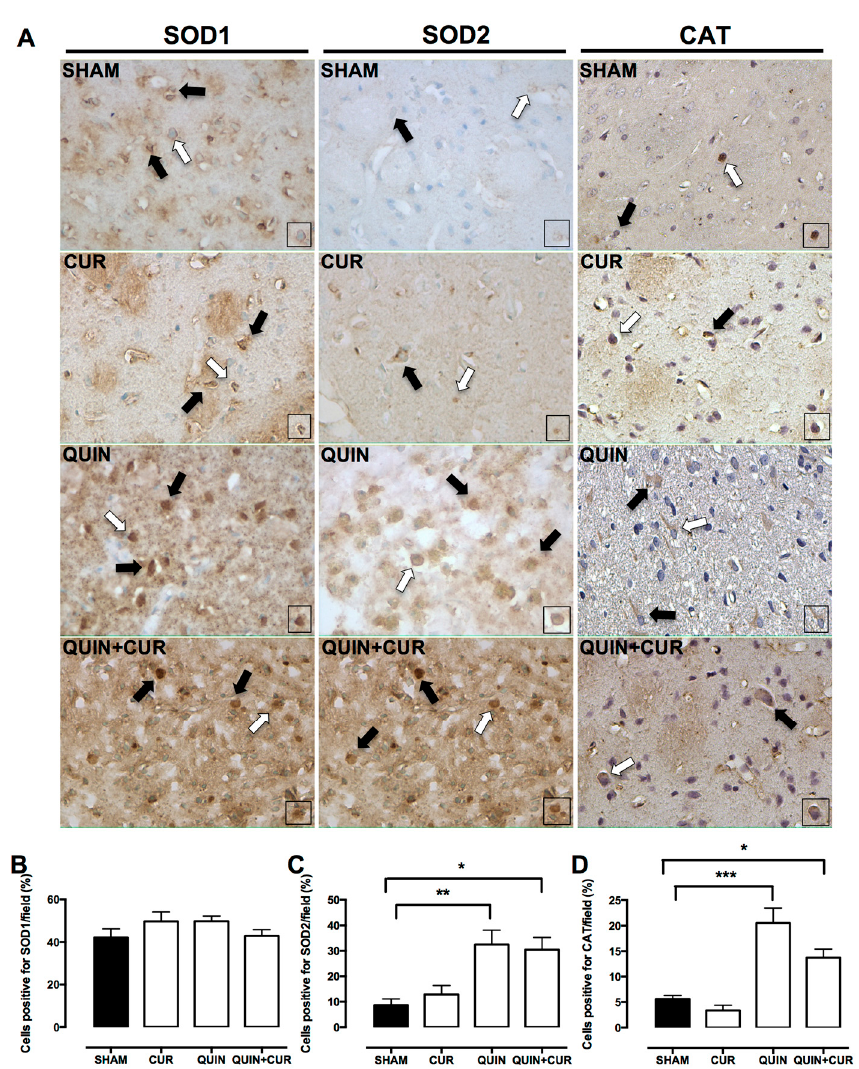
Figure 7. E ff ect of quinolinic acid (QUIN) and curcumin (CUR) on the protein levels of the enzyme regulated by the nuclear factor erythroid 2-related factor 2 (Nrf2). Immunohistochemistry assays were performed at day 7 after the quinolinic acid (QUIN) injection. Representative photomicrographs (40 × ) of cells positive for superoxide dismutase 1 (SOD1), superoxide dismutase 2 (SOD2), and catalase (CAT) in the striatum are presented ( A ). Black arrows indicate cells positive for each protein. Boxes represent the magnified cells positive indicated by white arrows. Graphs indicate the percentage of cells positive for ( B ) SOD1, ( C ) SOD2, and ( D ) CAT, counted in three randomly selected fields along the right striatum. Data are expressed as mean ± SEM (n = 3). * p < 0.05, ** p < 0.01, and *** p < 0.001. QUIN treatment significantly decreased the GSH levels in the right striatum (41.95 µ g GSH / mg protein) on day 7 compared to the SHAM group (68.3 µ g GSH / mg protein). CUR treatment (QUIN +